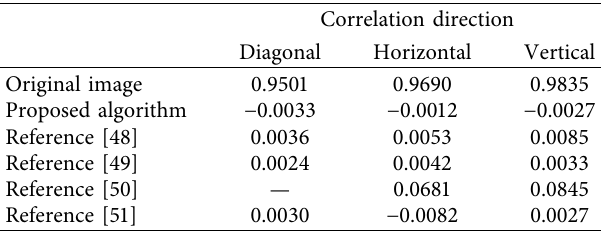
Table 4: The correlation coefficients between the proposed method and other algorithms.